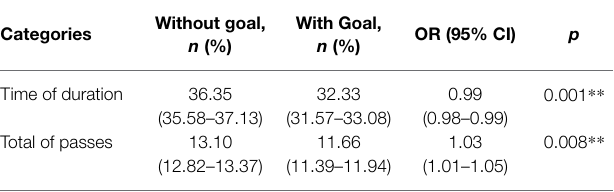
TABLE 6 | Differences in possession outcome according the duration and total of